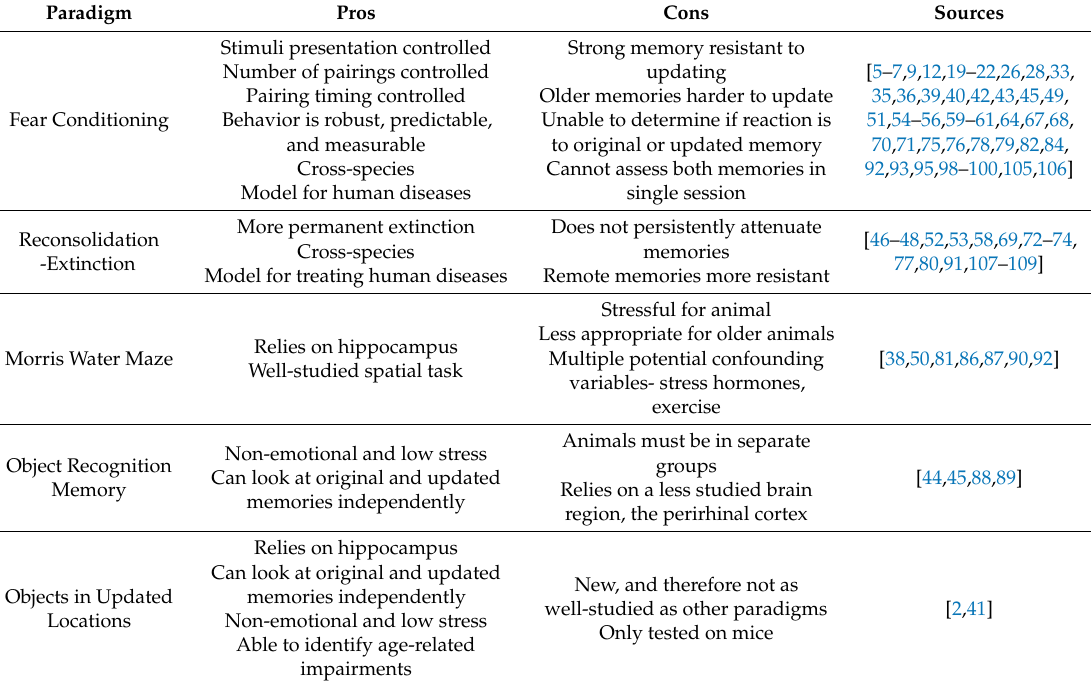
Table 1. Key reconsolidation-dependent updating studies from each behavioral paradigm covered in this